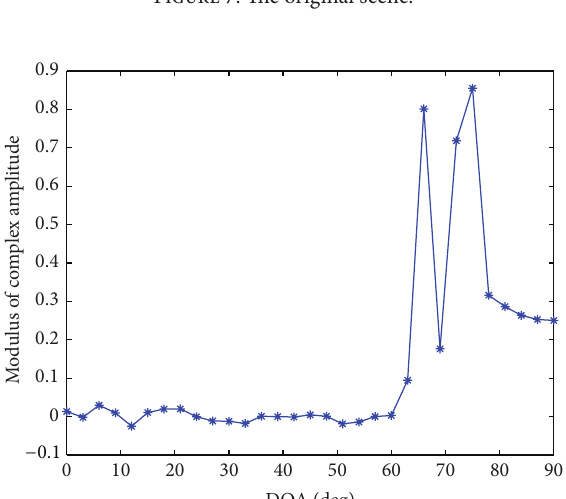
Figure 10: DOA estimation using Capon.